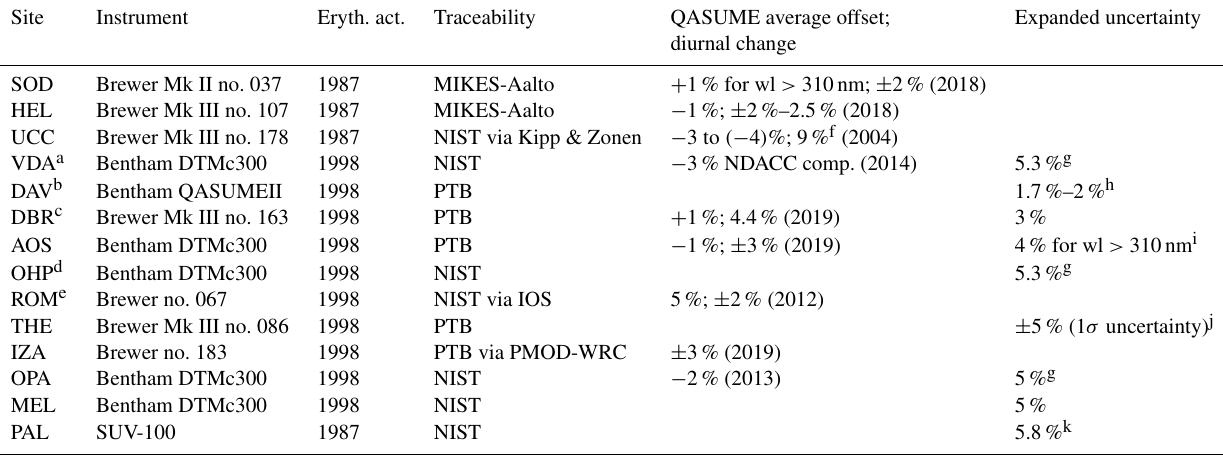
Table 3. Spectroradiometers used in the study. Data period is from 1 January 2018 to 31 August 2019, except for the instruments